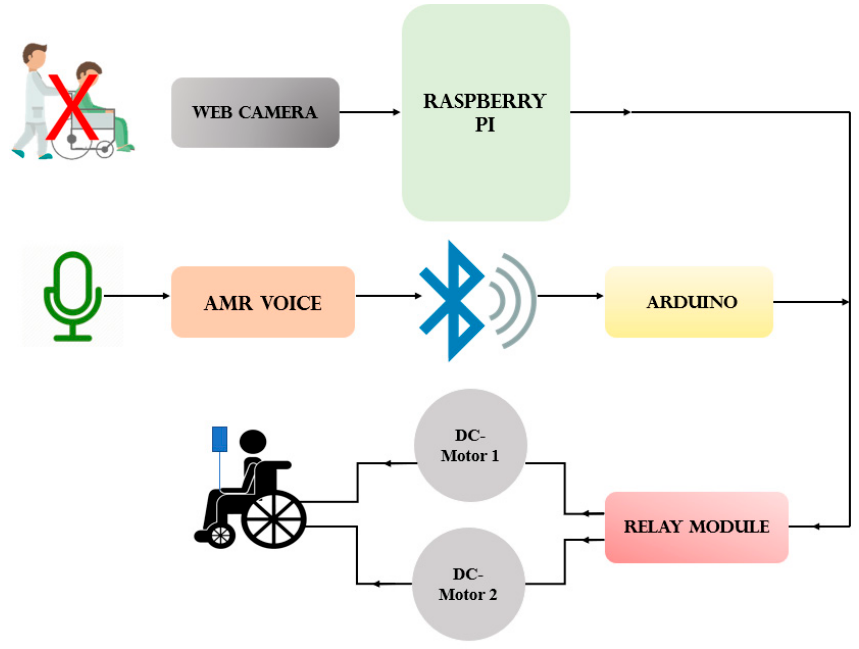
Figure 1. Block diagram of the system.